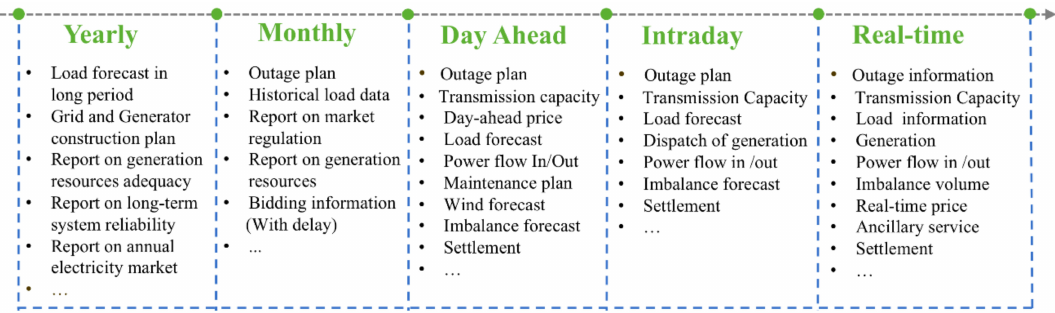
Figure 8. A general example of information disclosure